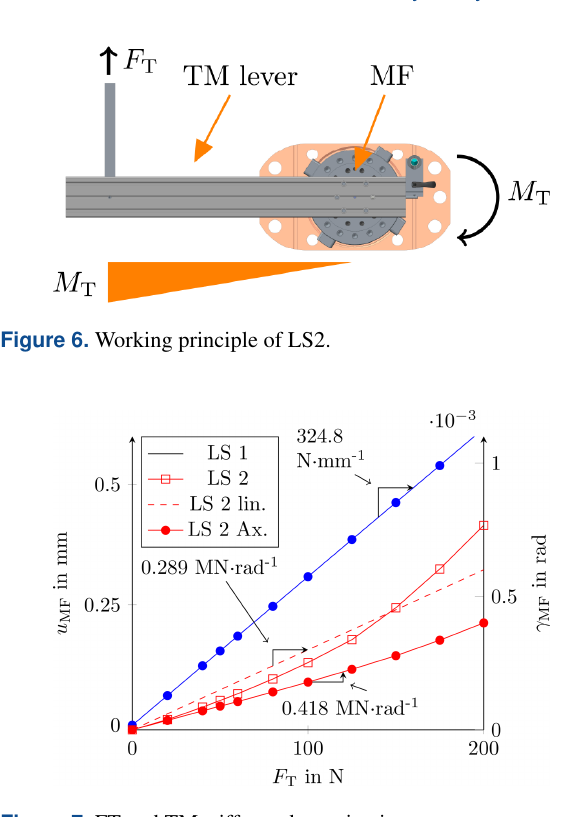
Figure 7. FT and TM stiffness